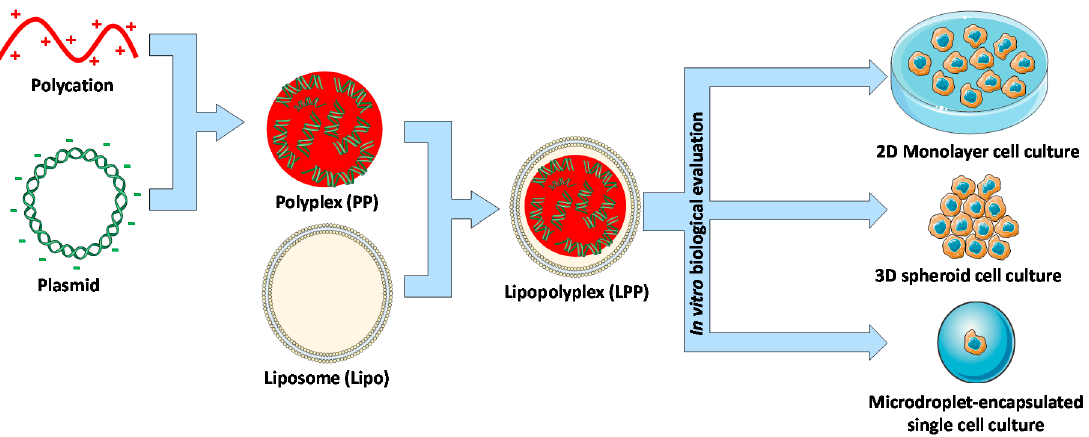
Figure 1. Schematic representation of the work carried out.